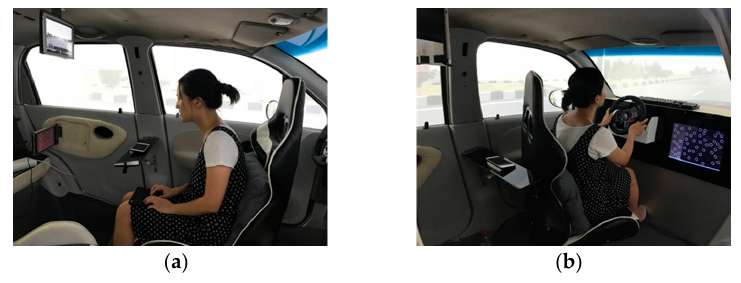
Figure 2. Seat configurations ( a ) facing rear and ( b ) facing